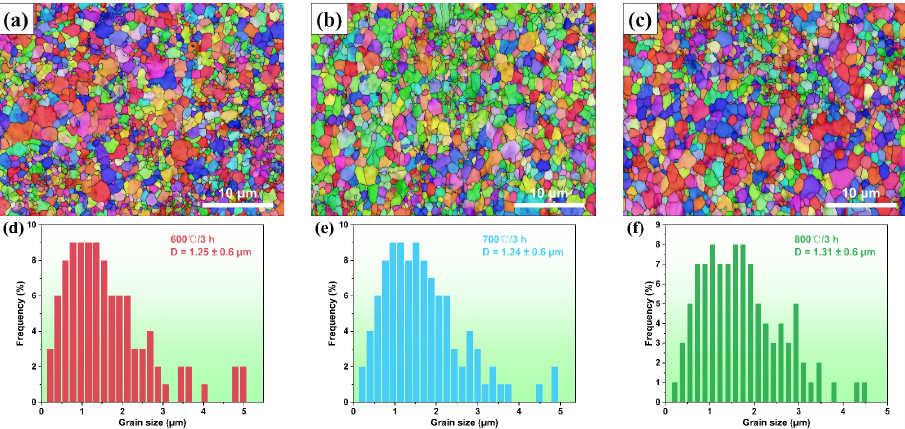
Figure 3. IPF image and grain size distribution of the annealed alloy. ( a , d ) 600 °C; ( b , e ) 700 °C; ( c , f ) 800 °C.